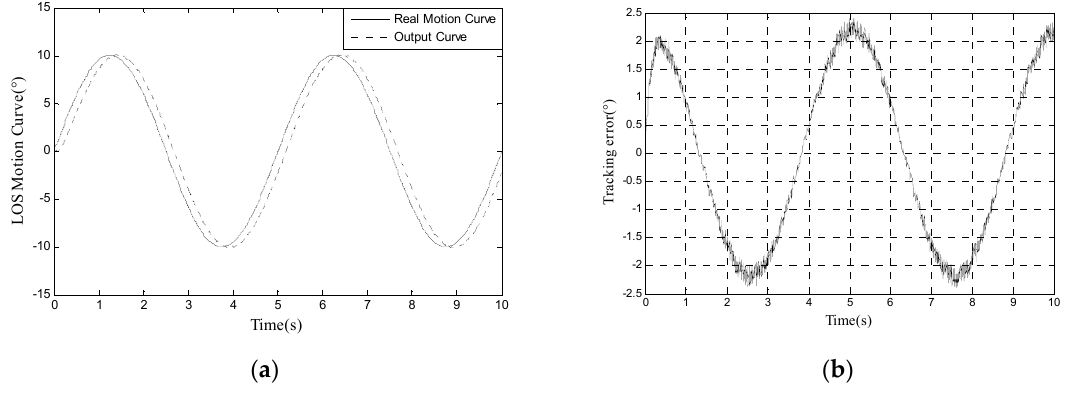
Figure 5. ( a ) LOS motion curve of tracking 10° 0.2 Hz signal without compensating miss-distance delay; and ( b )tracking error of tracking 10° 0.2 Hz signal without compensating miss-distance delay.